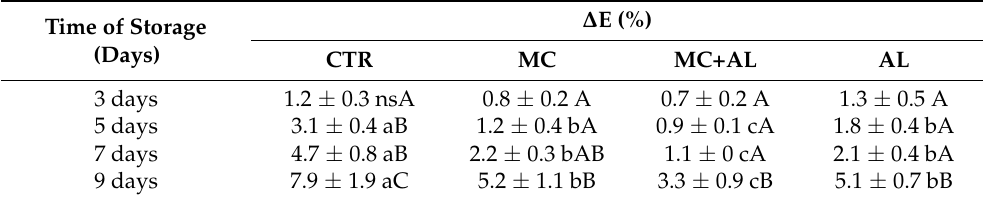
Table 4. ∆ E% of fruit slices of Actinidia deliciosa (Liang. Ferguson) coated with O. ficus-indica (OFI) mucilage (MC), or mucilage + A. arborescens (MC+AL) or A. arborescens (AL) not treated (CTR), just after being coated (0) and at 3, 5, 7, 9 days of storage at 5 ◦ C. Different lowercase letters indicate significant differences between treatments at each sampling date. Different capital letters indicate significant differences between sampling date for the same treatment. Tukeys’ significant test was applied at p ≤ 0.05. Data are means ± S.E. ( n =